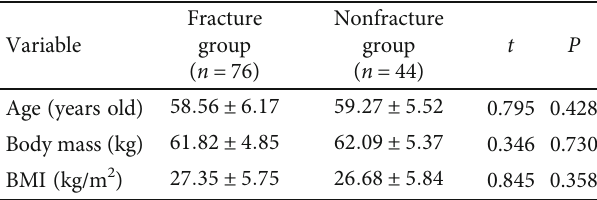
Table 1: Comparison of general information between the two